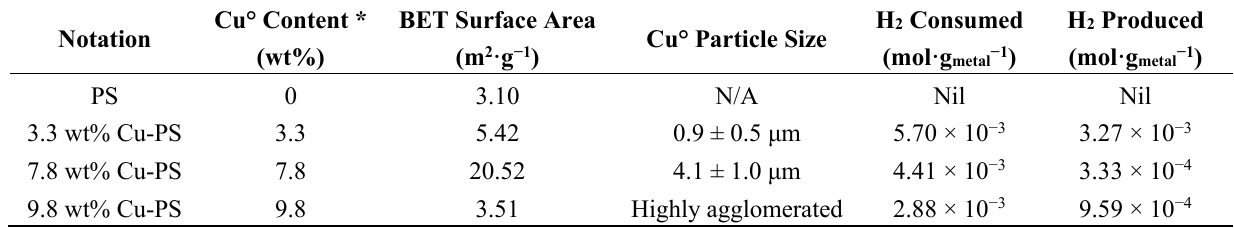
Table 1. Surface area, particle size of Cu°, H 2 consumption and production for various